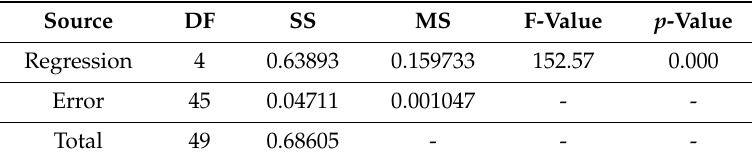
Table 10. Variance for PAT η at 1.4 Q d.